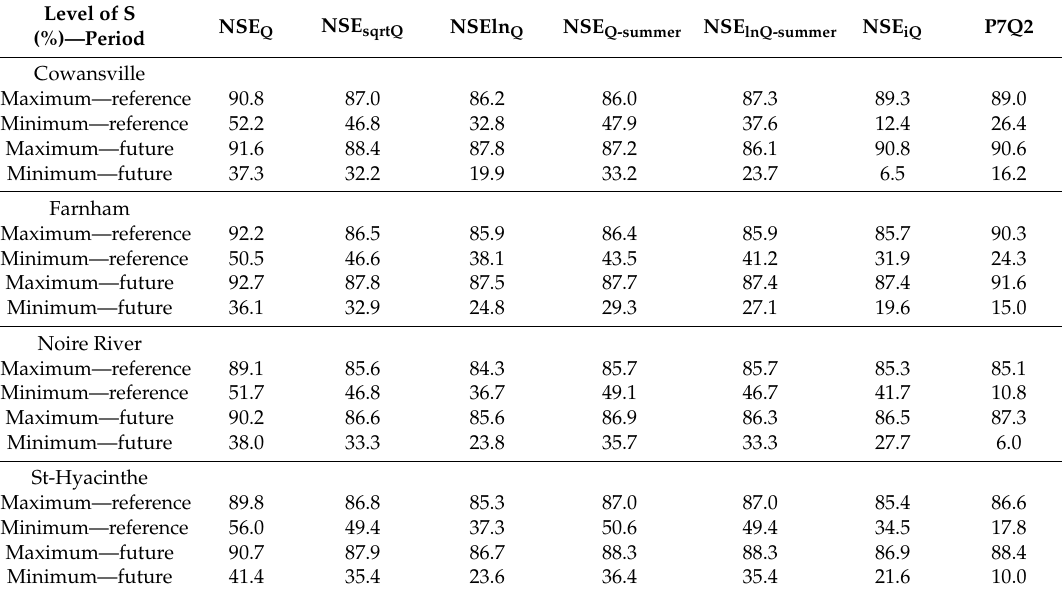
Table 3. Variation of the levels of the soil reservoir S for the GR4J